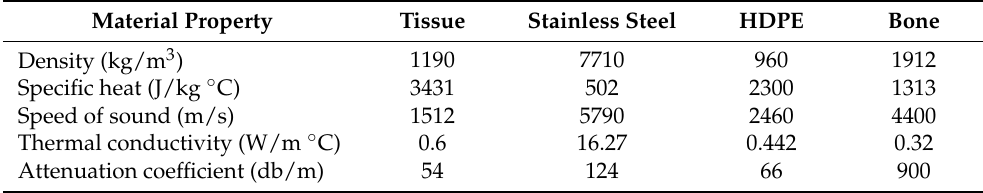
Table 1. Material properties of the soft tissue, inclusions, and bone [17]. Material